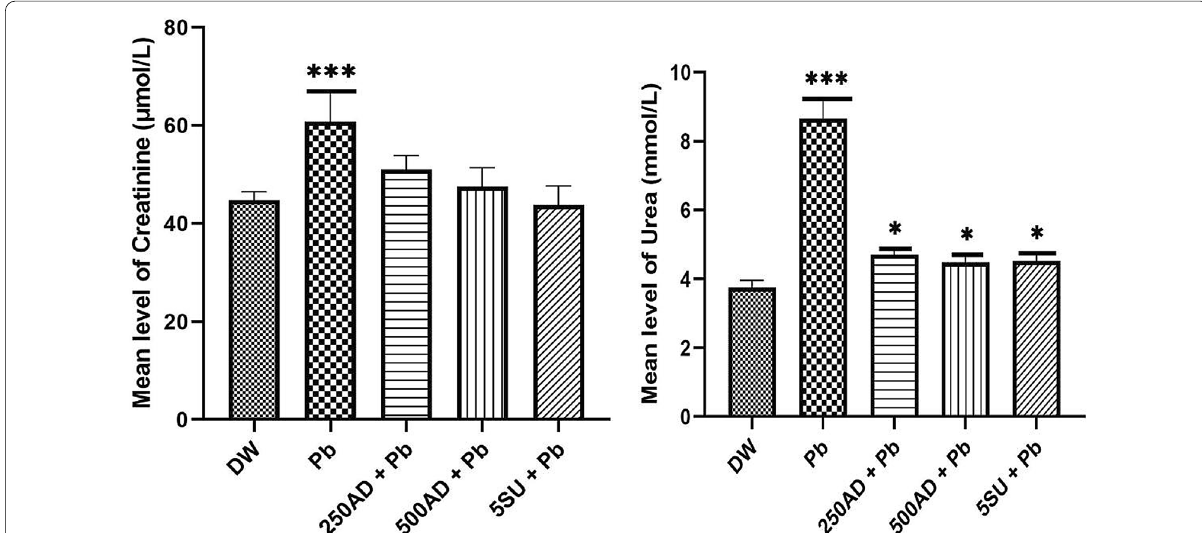
Fig. 2 Bar chats of the creatinine and Urea serum level after 6 weeks of the experiment. Data were analysed using one way ANOVA, followed with Tukey post hoc test, * p < 0.033; ** p < 0.002; *** p < 0.0001 for the experimental treated groups when compared with the control Group (DW). Data are mean SEM, n 5 rats for each group ± =